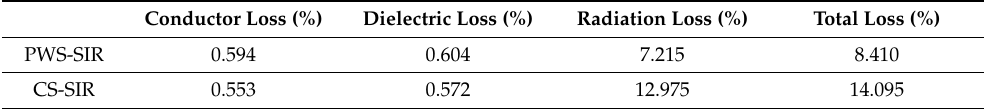
Table 1. The Loss Percentage of Two Resonators.